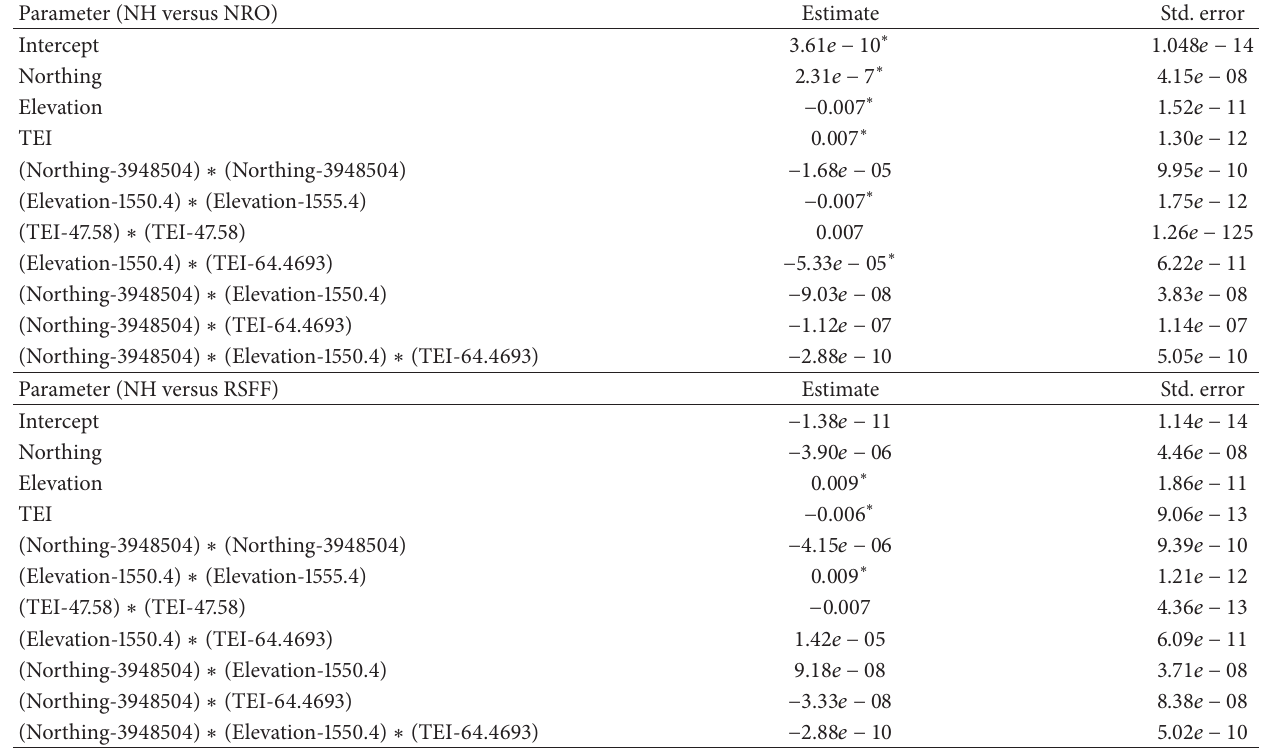
Table 3: The best approximating logistic model (Elevation + TEI) explaining presence or absence of northern hardwoods in areas above 1219.2.2 m in elevation of western North Carolina, eastern Tennessee, and southwest Virginia which composed our study area ( 𝑛 = 332 ). Sampling took place between June 2012 and January 2013. Forest types are notated as follows: northern hardwood (NH), northern red oak (NRO), and red spruce-Fraser fir (RSFF).